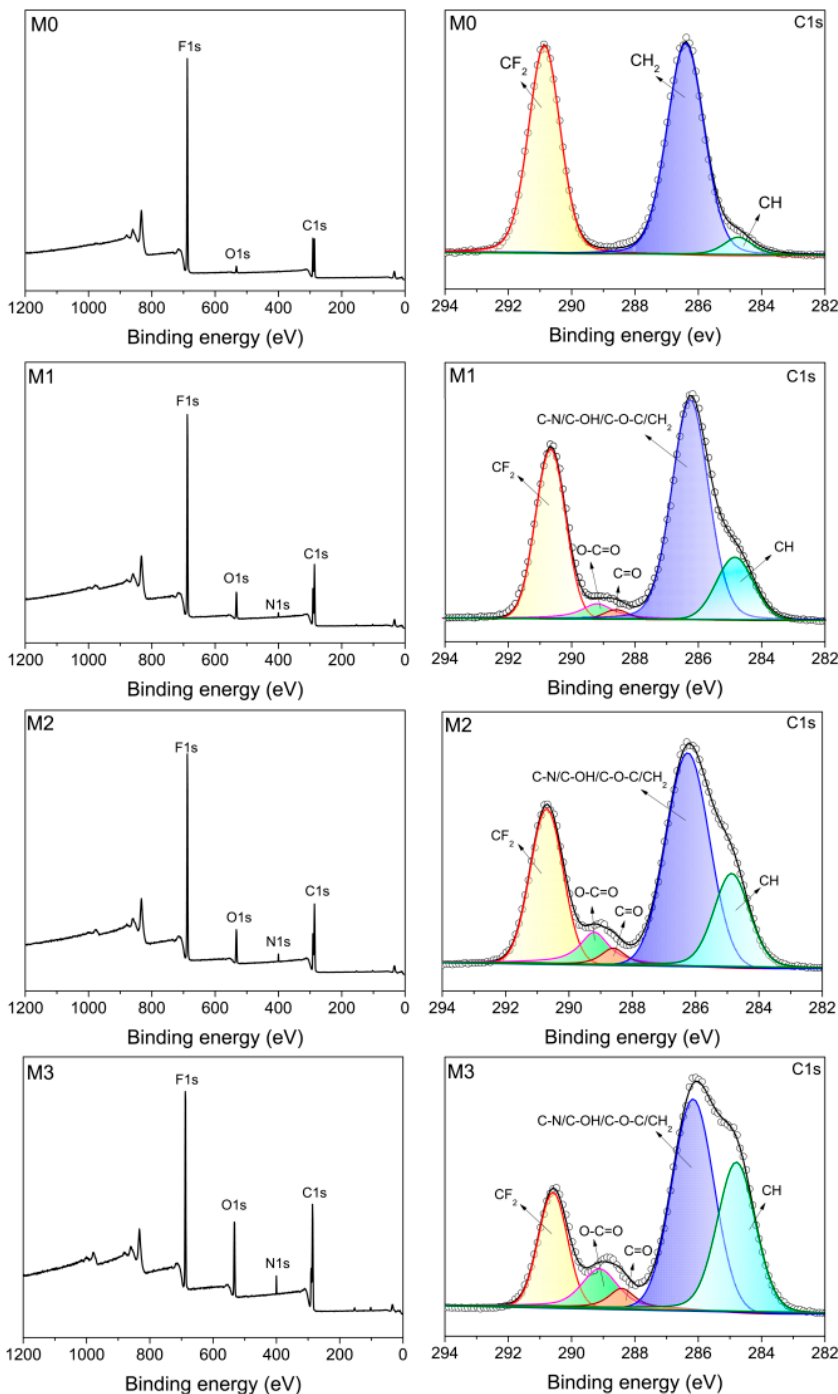
Figure 2. Wide-scan and C1s XPS spectra of membrane surfaces. Table 2 . Chemical compositions of membrane surfaces.